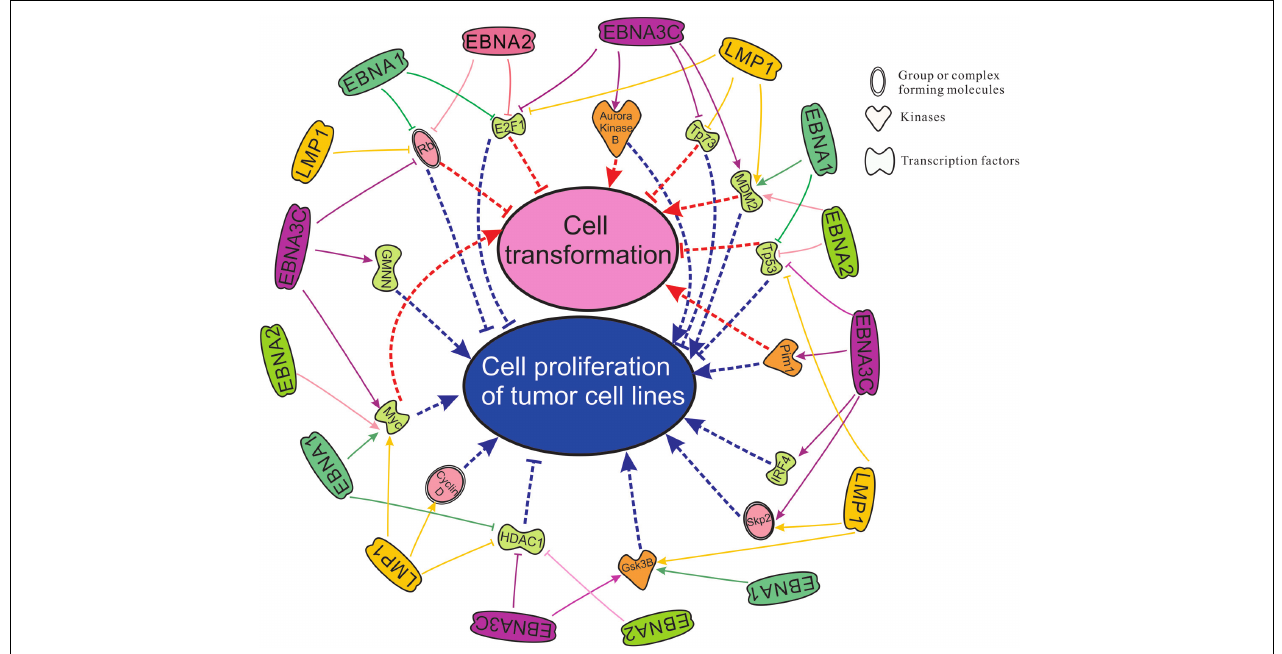
FIGURE 2 | Cell transformation and cell proliferation of tumor cell lines as mapped using the IPA software which demonstrates significant association with major cellular pathways. Here we have groups or complexes formed with cellular molecules including Rb, Skp2, CyclinD, the transcription factors E2F1, Tp73, Mdm2, Tp53, IRF4, Myc, HDAC1 and GMNN (Geminin), and kinases which include Aurora Kinase B, Pim1 and Gsk3B. We have also mapped the known regulation of these cellular antigens and their activities by the essential EBV latent antigens EBNA1, EBNA2, EBNA3C, and LMP1 for transformation and immortalization of EBV-infected cells leading to associated